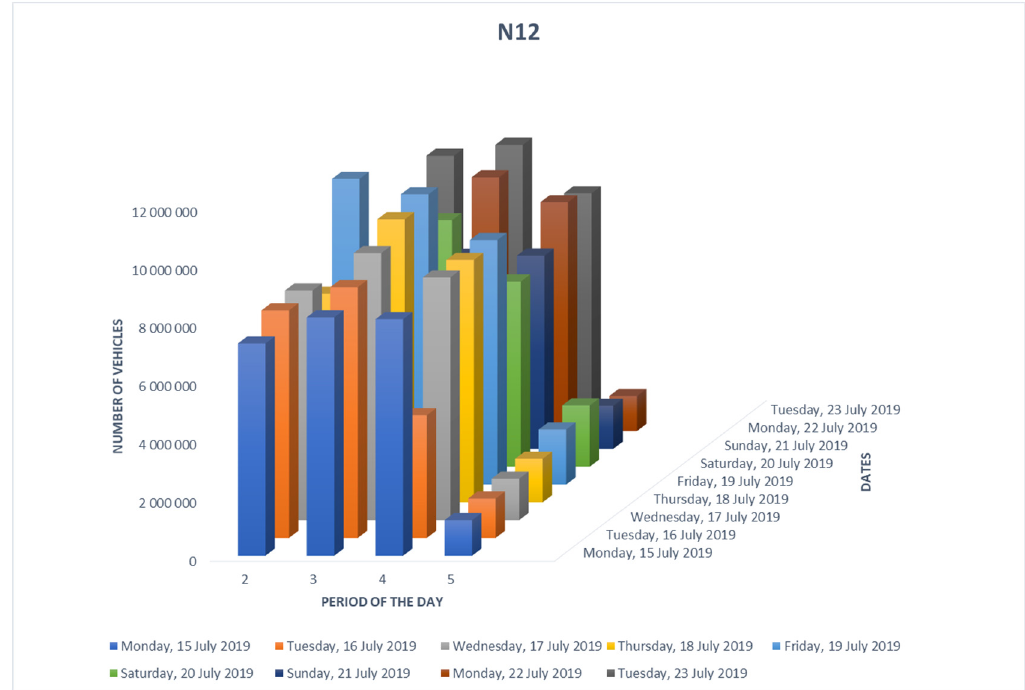
Infrastructures 2022 , 6 , x FOR PEER REVIEW